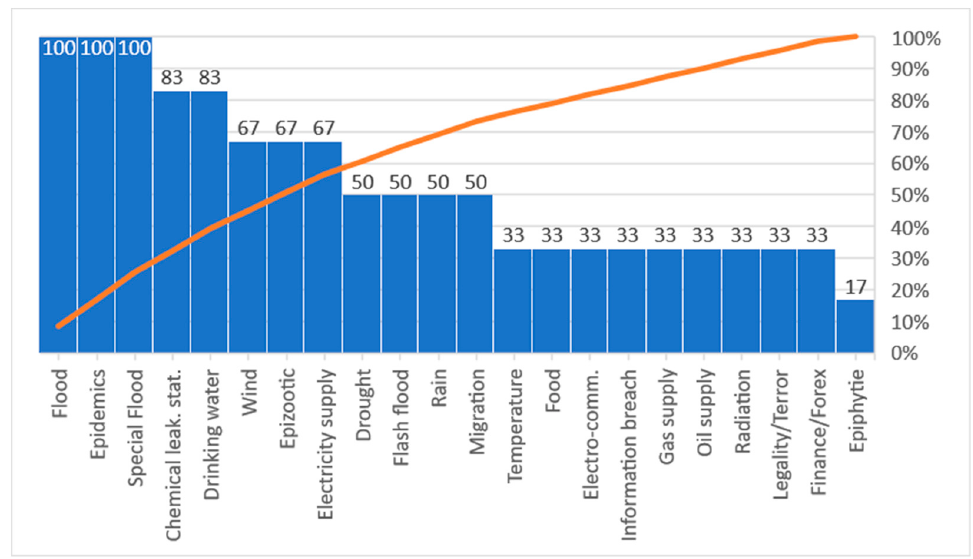
Figure 9. Percentage of regions with developed methodologies for dealing with CS.